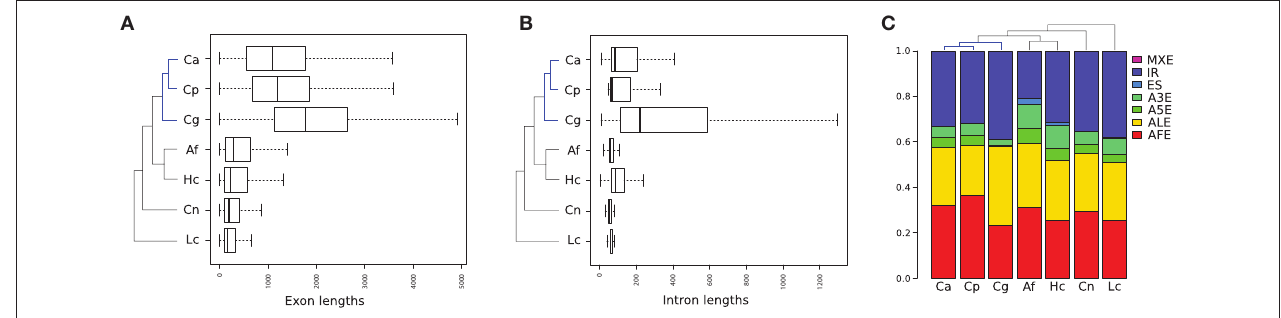
FIGURE 3 | Boxplot of lengths distribution of exons (A) and introns (B) for all annotated and predicted transcripts of the studied fungal species are shown. The proportion of AS patterns for each fungal species (C) including mutually exclusive exons (MXE), intron retention (IR), exon skipping (ES), alternative 3 ′ splice site (A3S), alternative 5 ′ splice site (A5S), alternative last exon (ALE), alternative first exon (AFE). AS events of predicted isoforms are compared to the annotated isoforms. For abbreviations of fungal species, see Figure 2 .